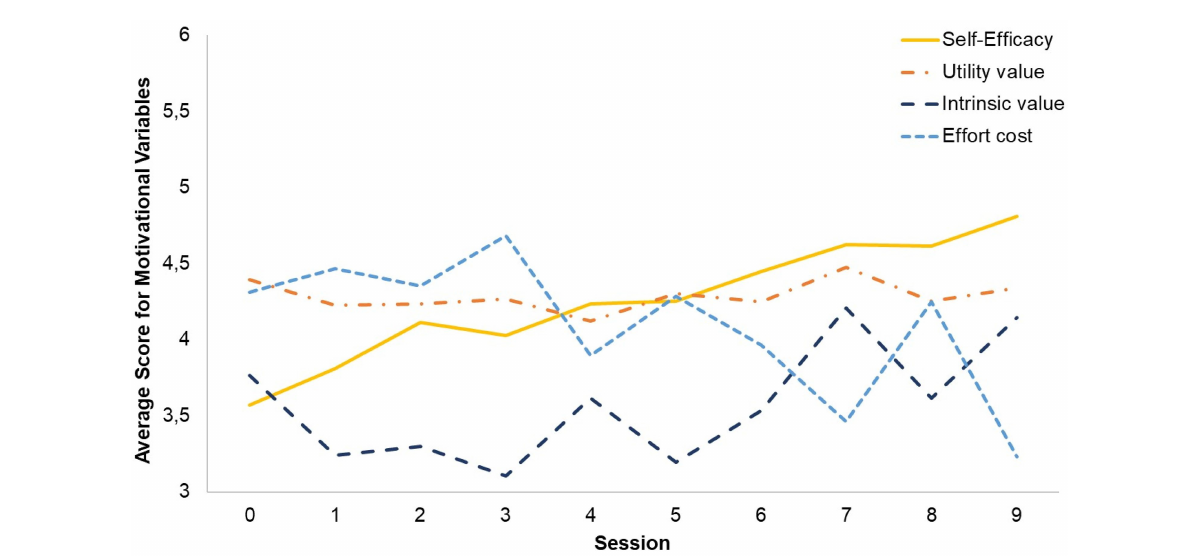
FIGURE 4 Average values for the four motivational variables measured for the 10 learning journals throughout the semester. X -axis starts at 3; N =